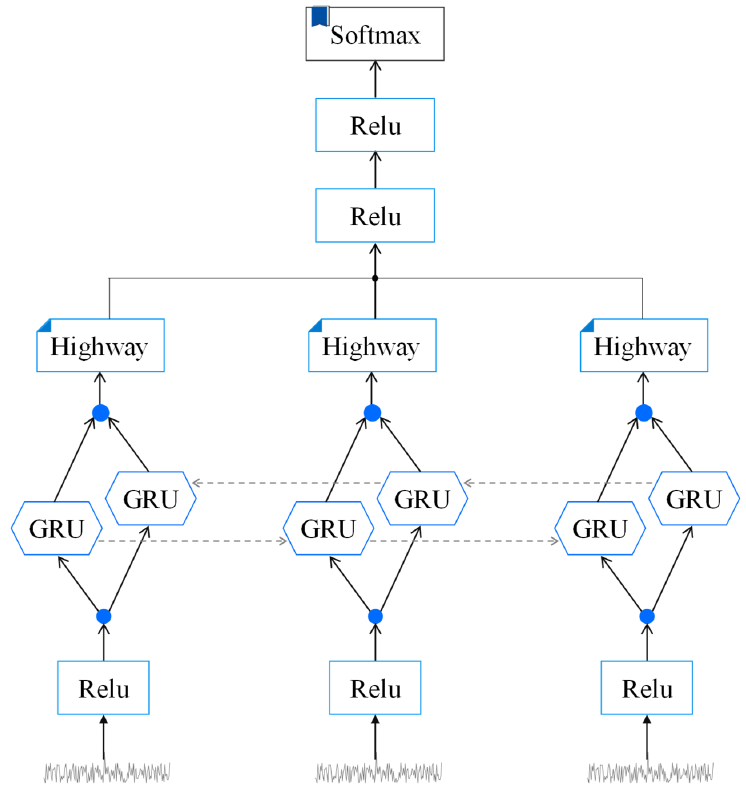
Figure 9. The mode architecture.